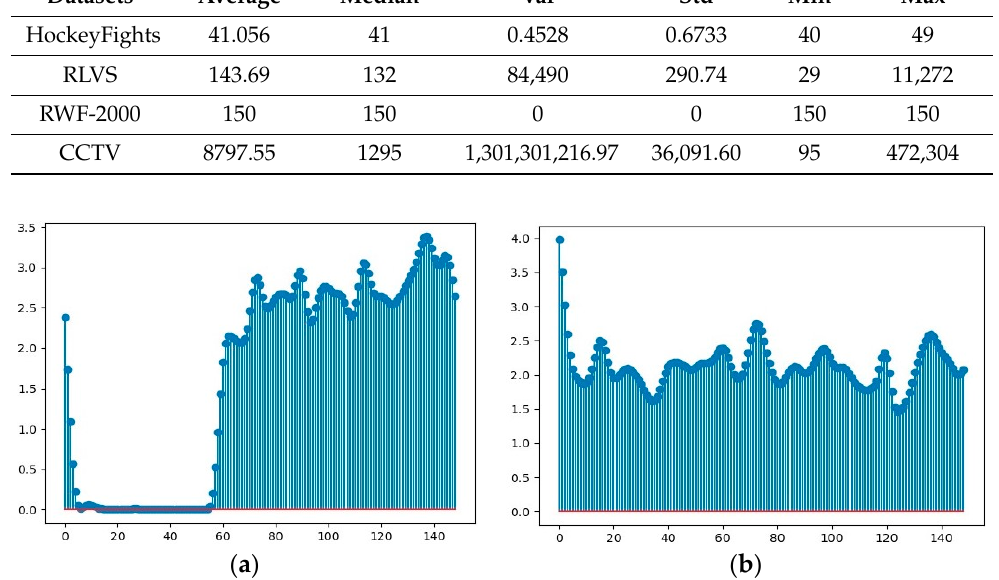
Table 5. Statistics on the number of video frames in the violence dataset.